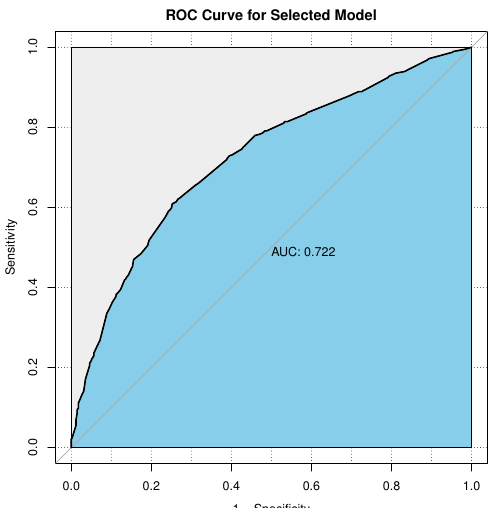
Figure 1. Receiver Operating Characteristics (ROC) curve and Area under the Curve (AUC) for the logistic regression